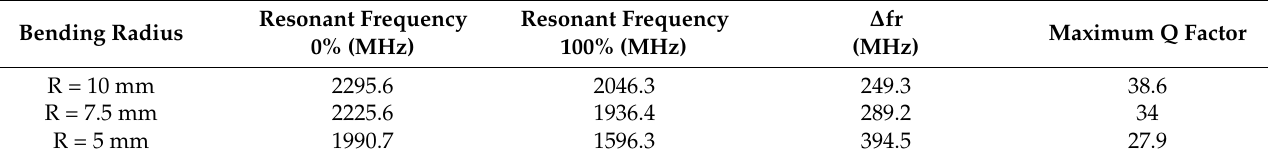
Table 2. Effect of bending radius on the sensitivity Q factor of the bent sensor.